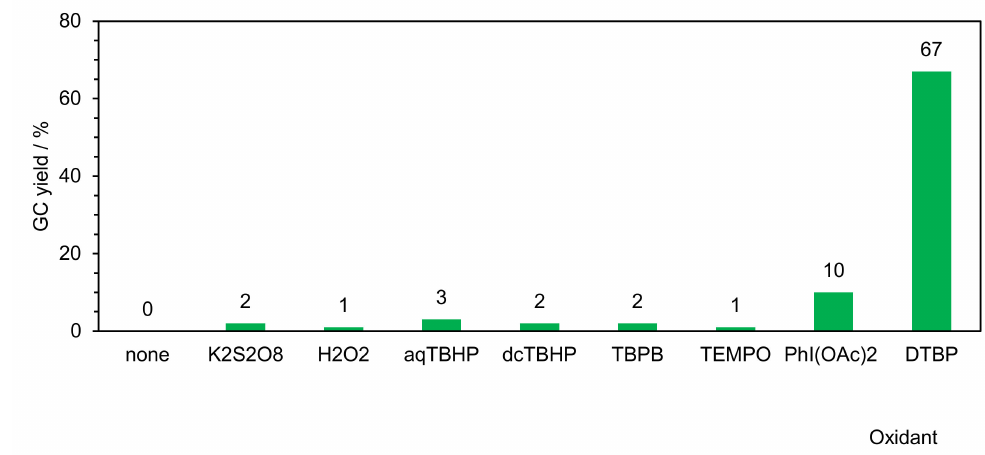
Figure 7. Effect of the oxidant on the product yield. Reaction conditions: 1,1-diphenylethylene (0.3 mmol); THF (1 mL); KI (20 mol%); oxidant (4 equiv.); Cu 1 Ce 0.7 Si catalyst (5.6 mg); 120 ◦ C; under air for 20 h. DTBP: di- tert -butylperoxide; aqTBHP: tert -butyl hydroperoxide in water; dcTBHP: tert -butyl hydroperoxide in decane; TBPB: tert -butyl peroxybenzoate, TEMPO: (2,2,6,6-